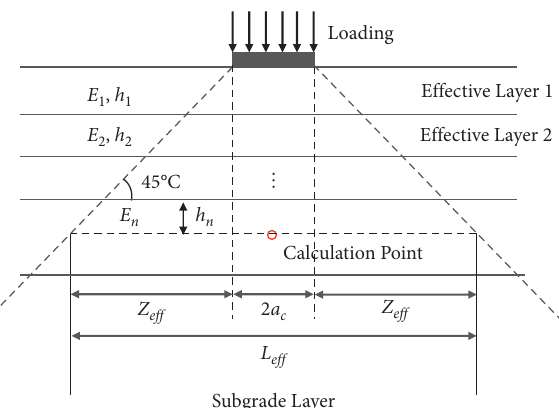
Figure 5: Schematic diagram of the length of the stress